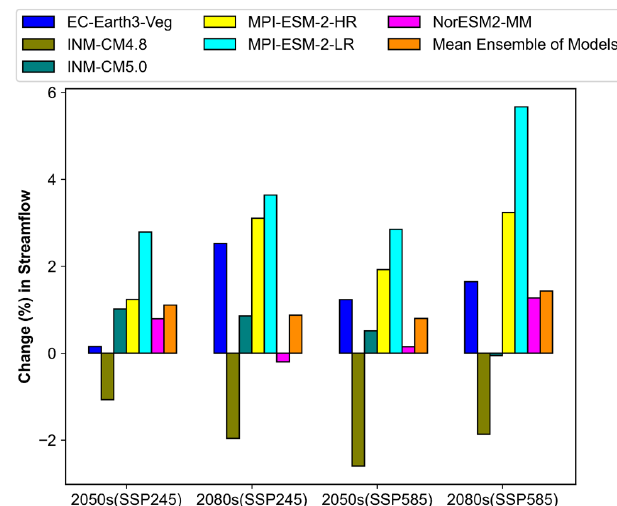
Figure 19. Predicted change in the mean annual streamflow of the Sutlej River with respect to the reference period (1979–2009) in the 2050s and 2080s under SSP245 and SSP585 scenarios for different